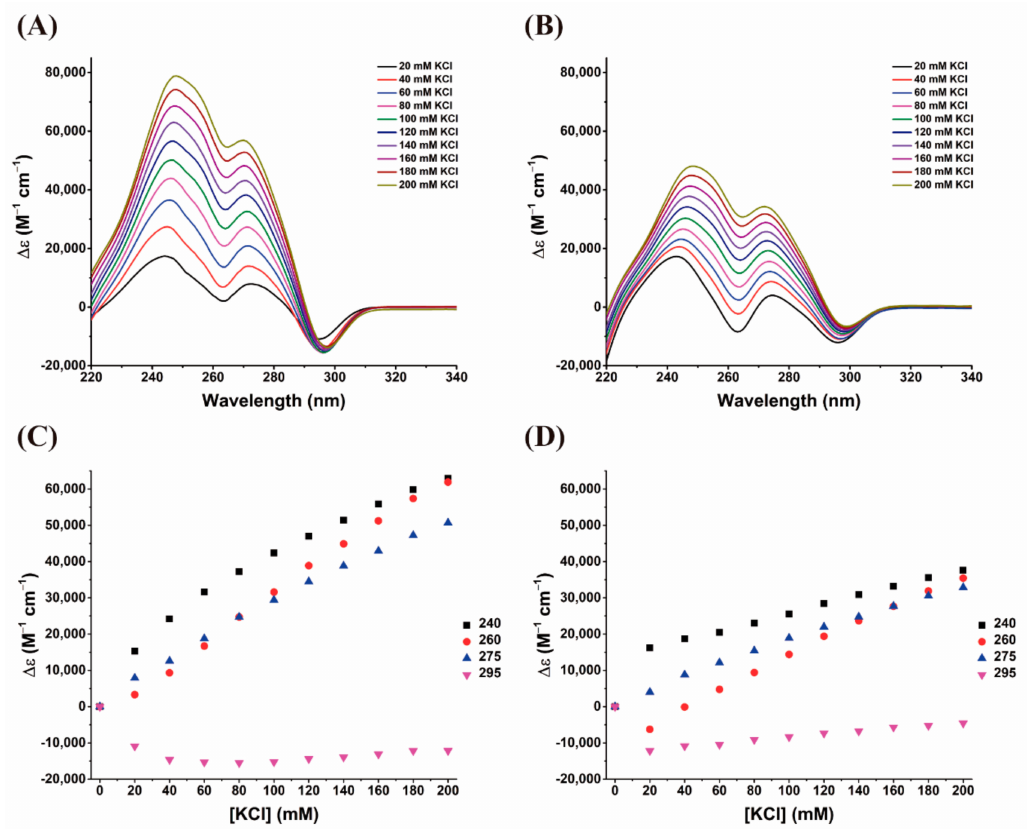
Figure 5. IDS steady-state measurements upon addition of increasing amounts of K + . In ( A , B ) are depicted the IDS resultant from salt titration performed to both oligonucleotides and in ( C , D ) are plotted the absorbance variation in selected wavelengths (240, 260, 275, 295 nm) for AS1411-N6 and AS1411,